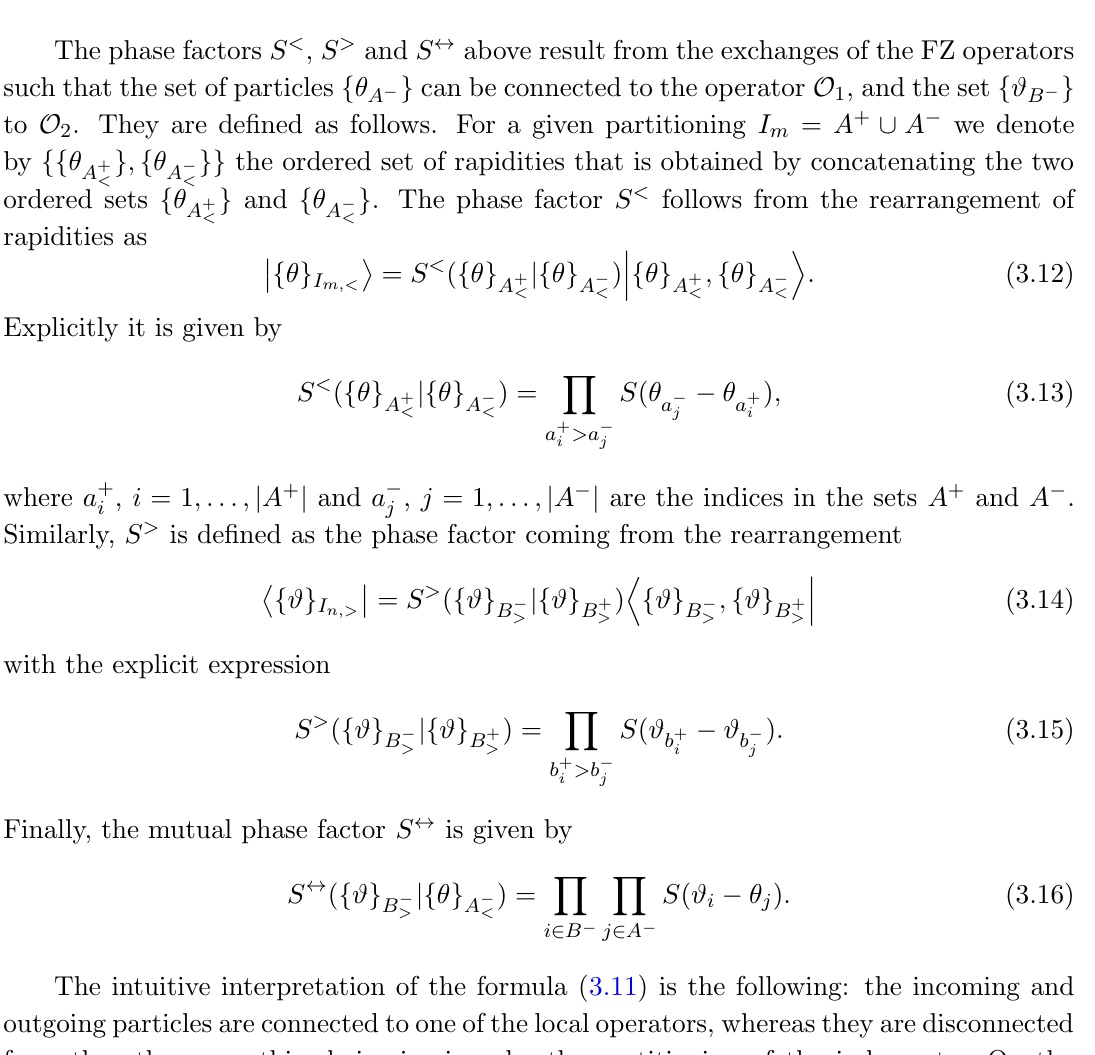
Figure 1 . Graphical interpretation of the integral representation (3.11) for the bi-local form